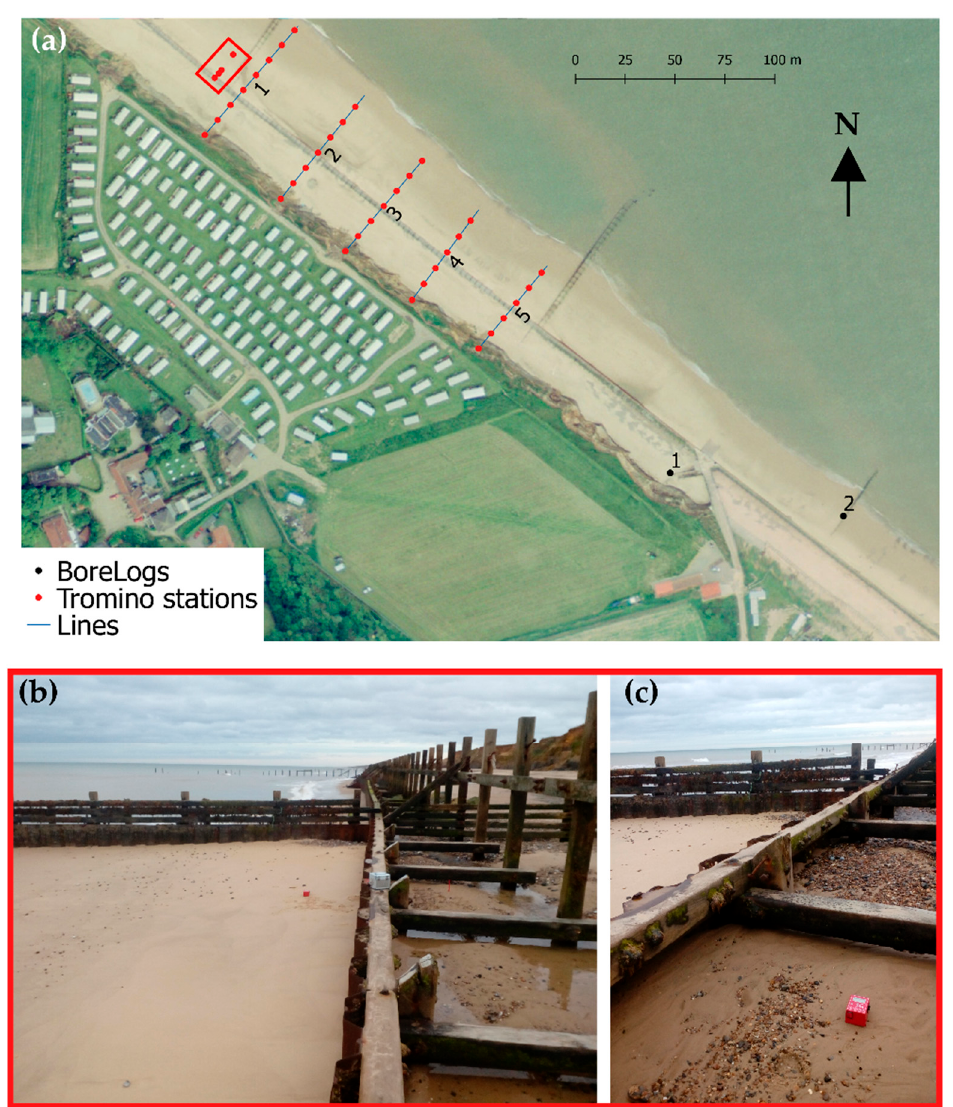
Figure 6. Passive seismic survey recorded locations; ( a ) 34 points along five lines (i.e., lines 1 to 5) were initially recorded covering the beach from the cliff toe to the seaward limit of the dry beach. Four additional points were recorded during the day, these are shown as points within a red rectangle; ( b ) detail of the extra station recorded immediately in front of the palisade and; ( c ) detail of extra station recorded immediately behind the palisade. Beach levels on stations shown in ( a , c ) were similar within ±10 cm.